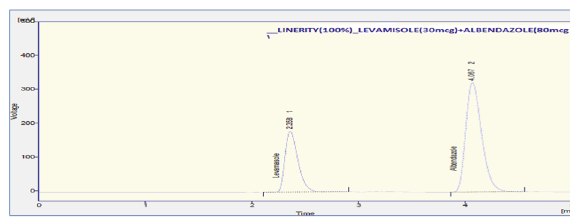
Figure 4: Chromatogram of levamisole and albendazole preparation-3.